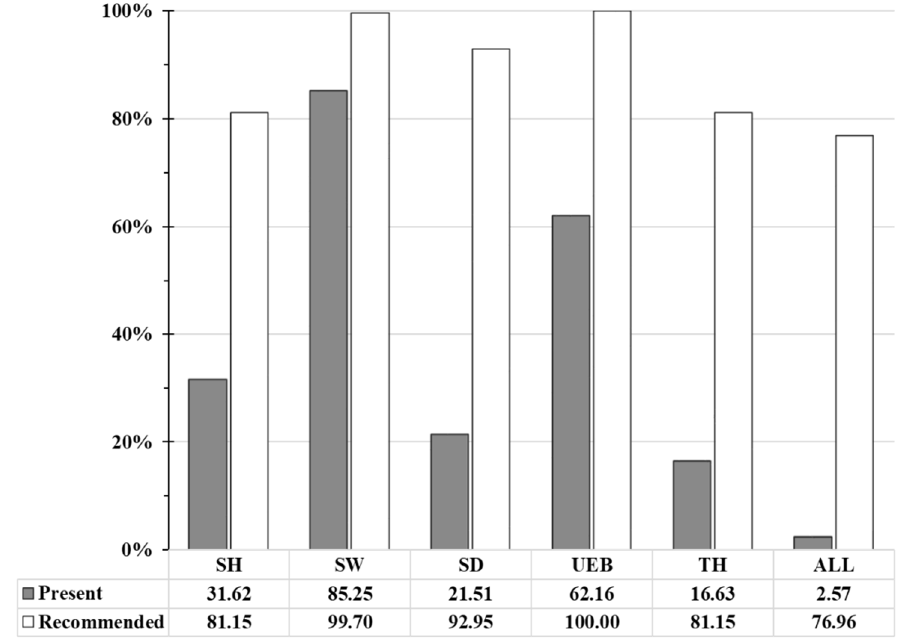
Figure 6. Comparison of match rate between the present and recommended specifications of the submarine console.